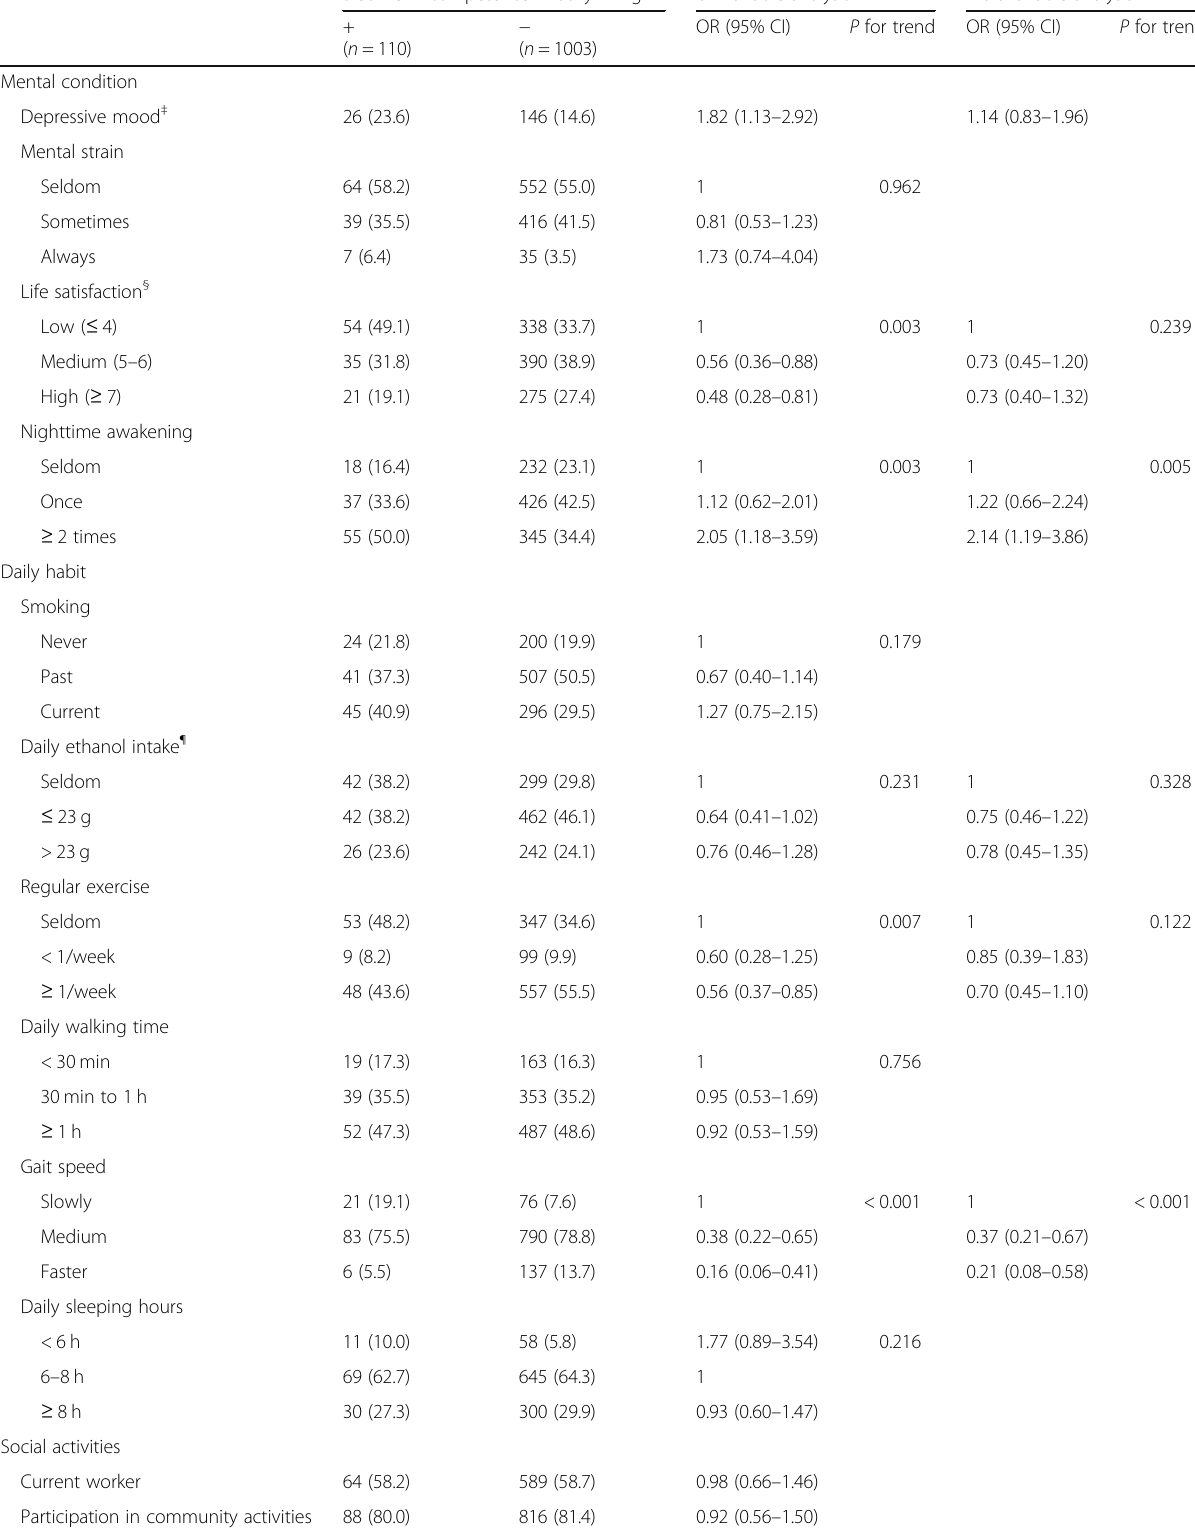
Table 2 Association of lifestyle/psychosocial factors at age 64 years with reduced competence in daily living at age 70 years